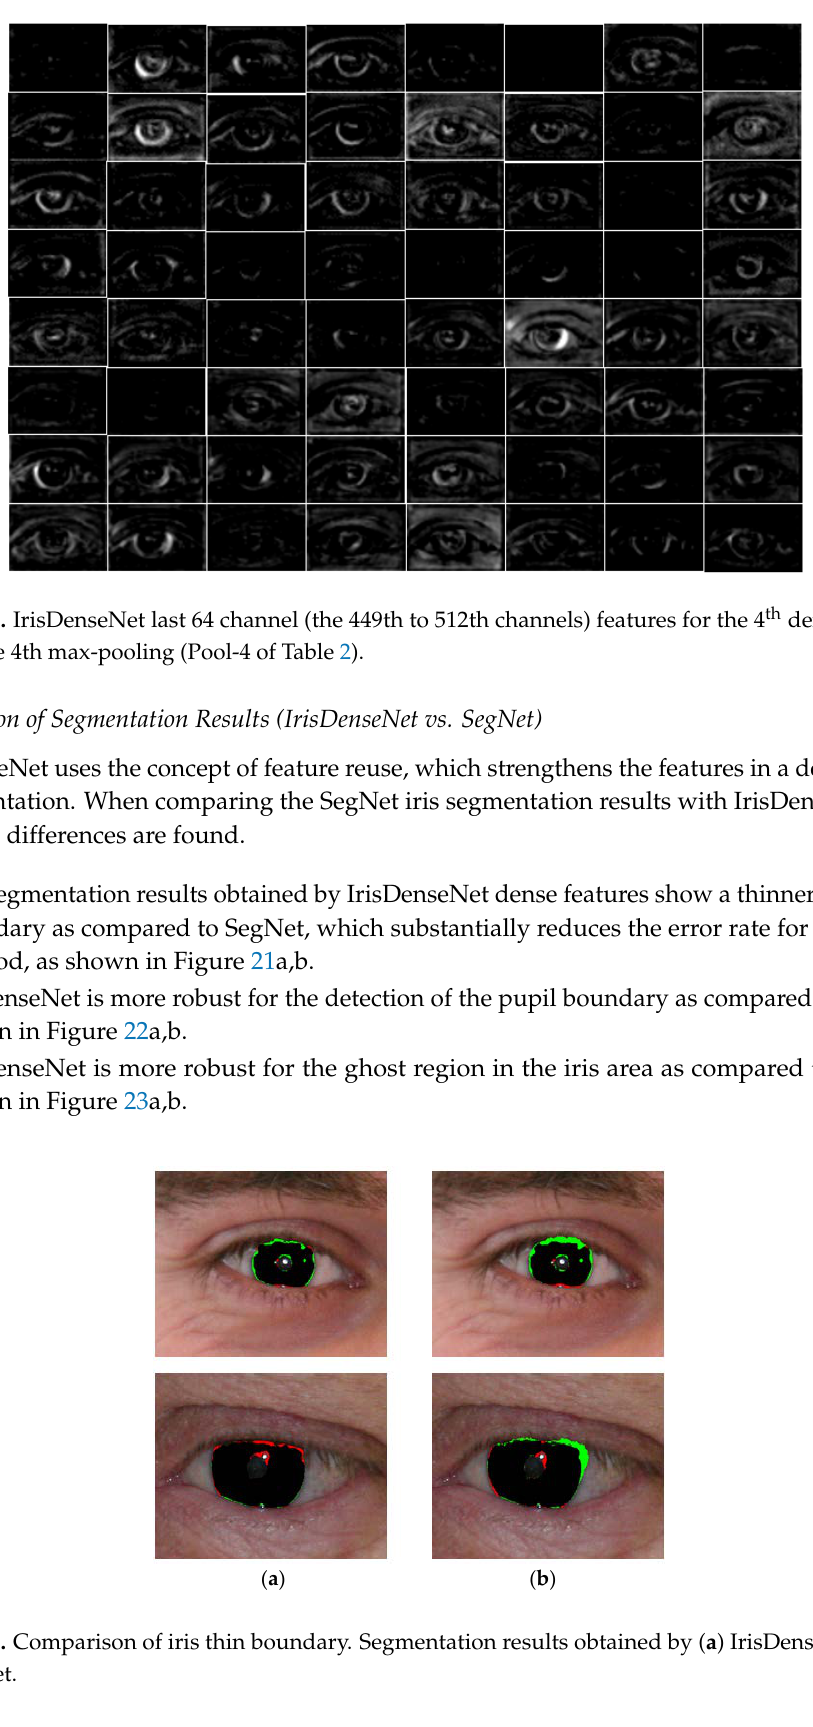
Figure 21. Comparison of iris thin boundary. Segmentation results obtained by ( a ) IrisDenseNet and ( b ) SegNet.